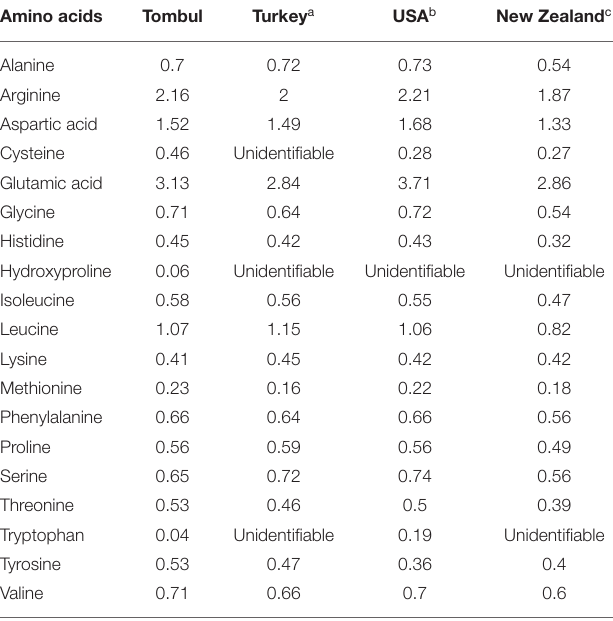
Table adapted from Alasalvar et al. (2003b) and Alasalvar and Shahidi (2008). “a” varieties Aci, Cavcava, Çakildak, Fo¸sa, Incekara, Kalinkara, Kan, Karafindik, Kargalak, Kus„ Mincane, Palaz, Sivri, Tombul, Uzunmusa, Yassi Badem, and Yuvarlak Badem. “b” unknown varieties. “c”: varieties Whiteheart, Barcelona, Butler, Ennis, Tonda di Giffoni, and